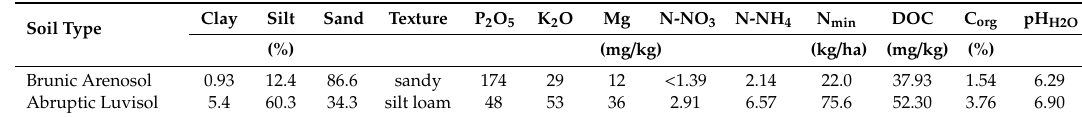
Table 1. Basic characteristic of tested